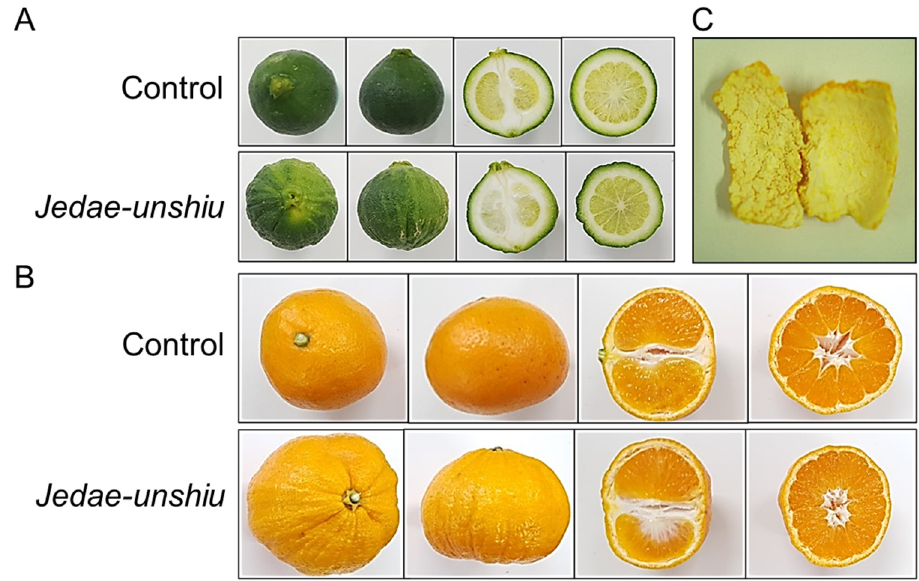
Figure 2. Morphological comparison between Jedae-unshiu and control fruits. ( A ) Immature fruits, ( B ) Mature fruits, ( C ) Albedo of control (left) and Jedae-unshiu (right). In a comparative analysis between Jedae-unshiu and control fruits, no significant differences in horizontal length, vertical length, or fruit weights were observed in the 3 years from 2018 to 2020. However, over these 3 years, the average peel thickness was 2.30 ± 0.30 mm for the control, compared with 3.05 ± 0.65 mm for Jedae-unshiu , indicating